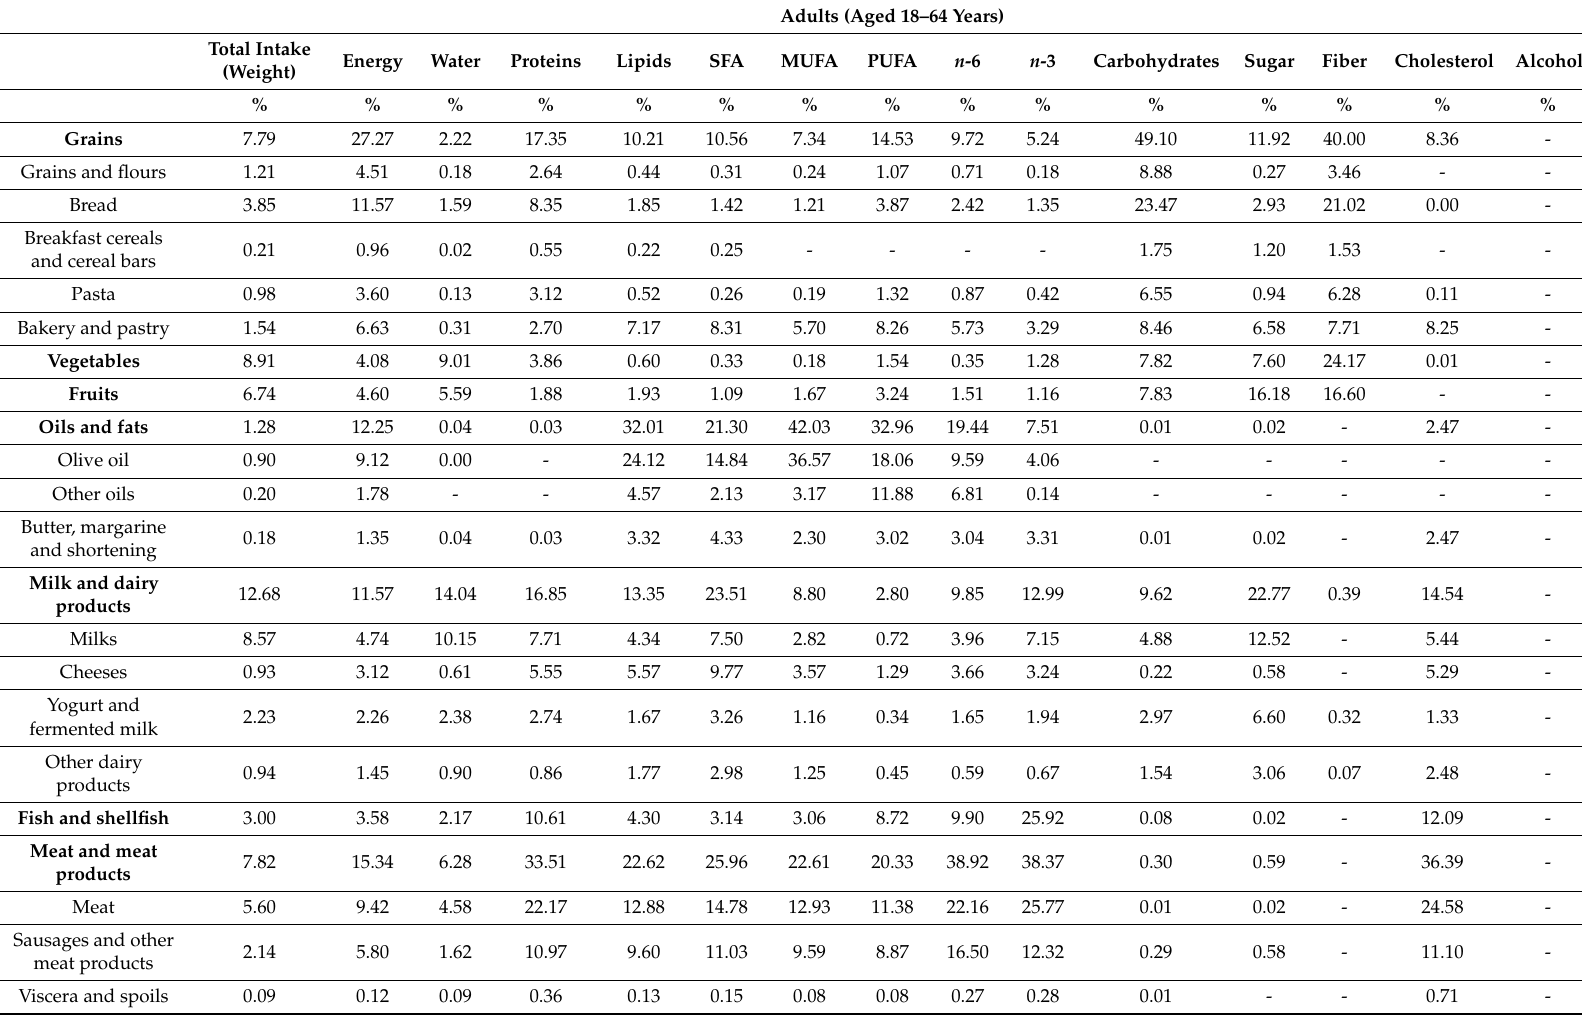
Table 6. Dietary sources of nutrients (%) from food groups/subgroups in the Spanish ANIBES study population: adults aged 18–64 years ( n =